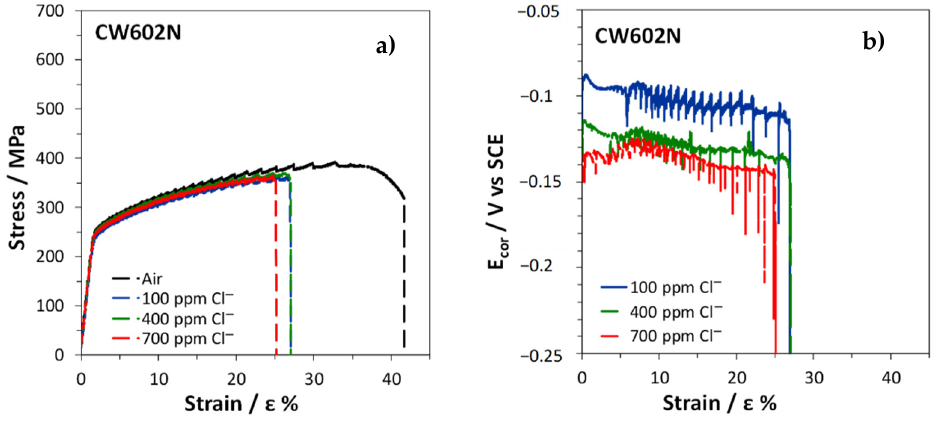
Figure 14. SSRT on CW602N: ( a ) stress vs. strain curves obtained in air and in SDW solutions and ( b ) E cor values recorded in SDW solutions.